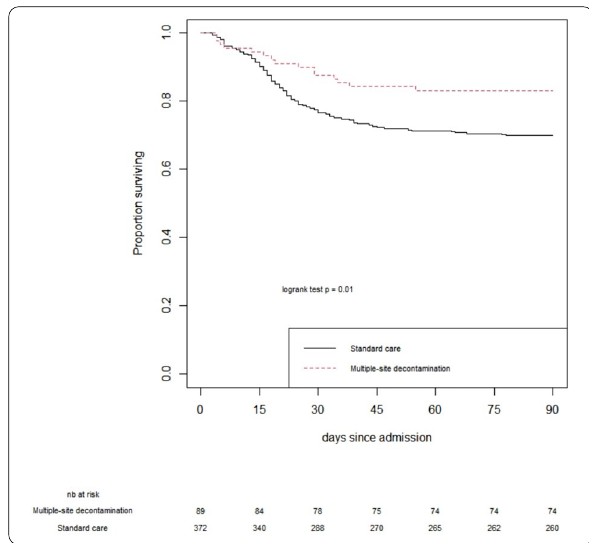
Figure. Survival